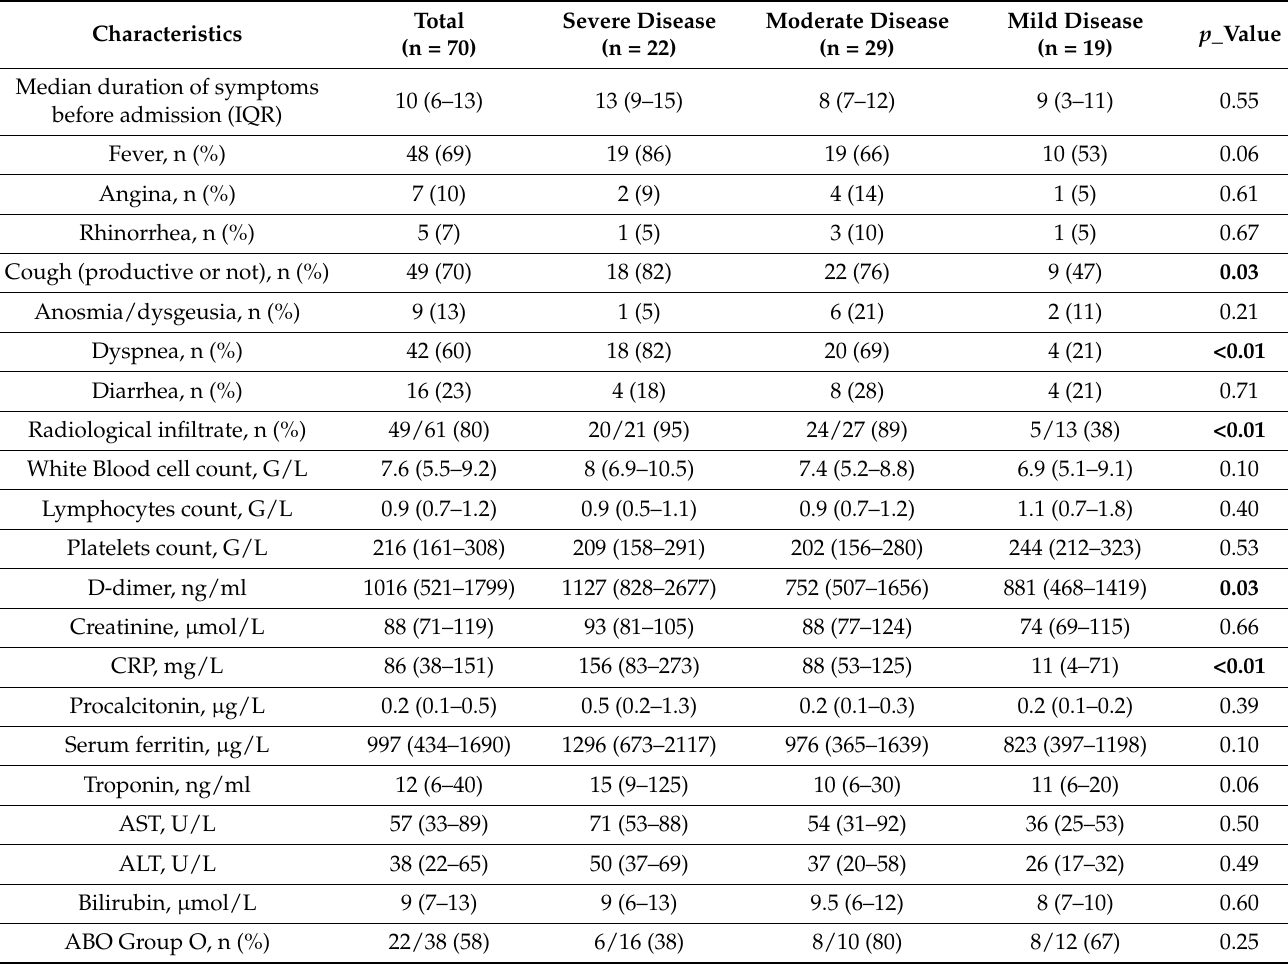
Table 2. The clinical characteristics and laboratory values of patients on